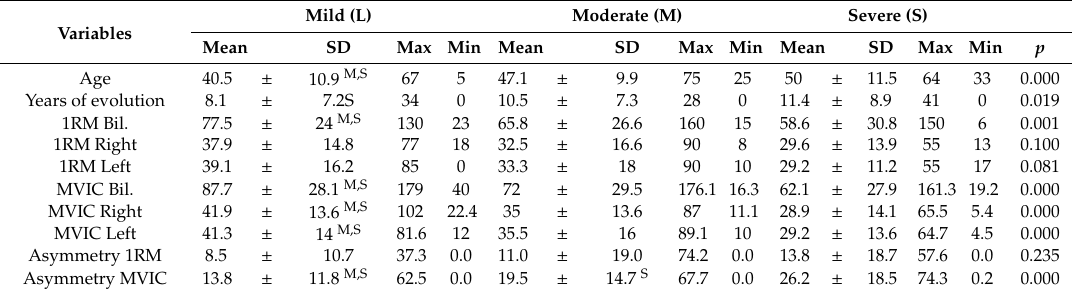
Table 5. Age, years of evolution, and force variables by neurological disability